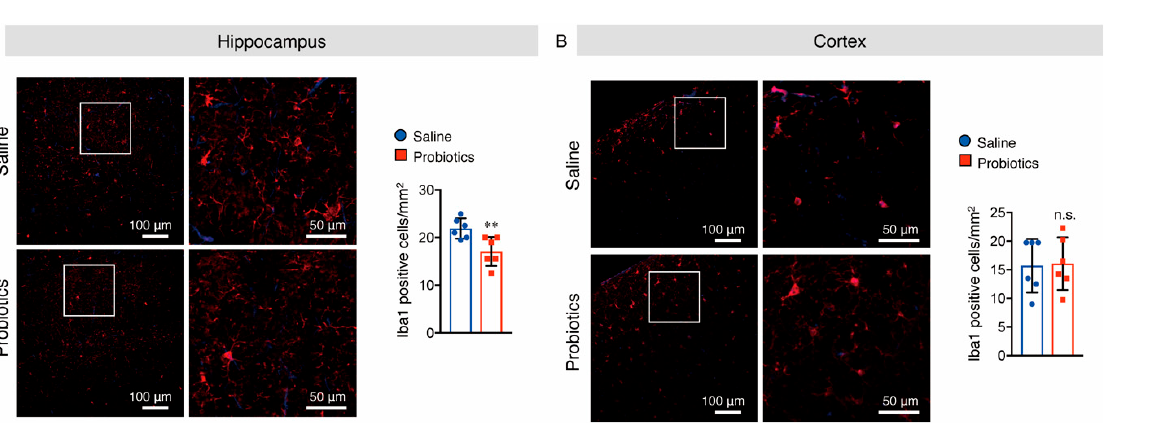
Figure 7. Oral supplementation of B. breve MCC1274 attenuates microglial activation in the hippocampus of WT mice. Iba1 immunostaining in the hippocampus ( A ) and cortex ( B ) of WT mice. Representative images of brain sections stained with an anti-Iba1 antibody (red) and DAPI nuclear counterstain (blue) (left panel). The number of Iba1 + cells in the hippocampus ( A ) and cortex ( B ) (right panel). Data are represented as mean ± SD, n = 6 per group; n.s. no significant difference; ** p < 0.01 compared with the saline group, as determined by Student’s t -test.